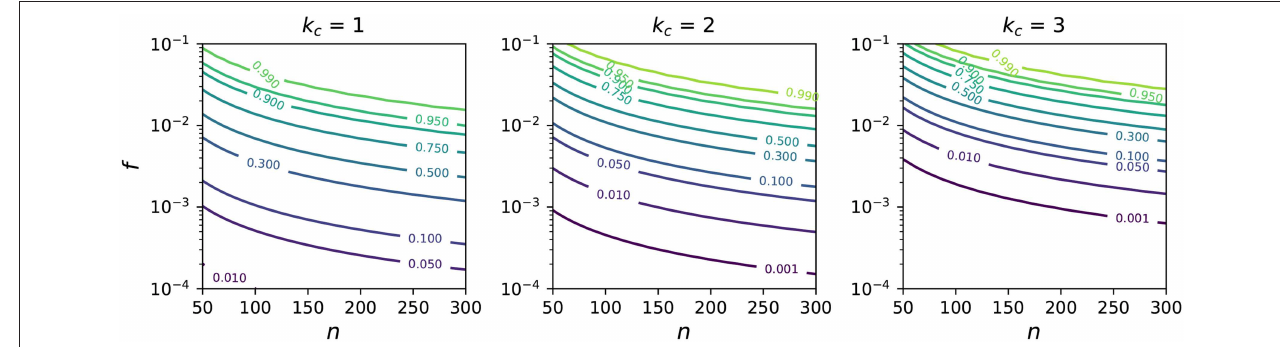
FIGURE 2 | Probabilities of dating enough grains from the youngest constituent to compute an MDA, given that k c grains are required to compute an MDA and that the grains belonging to the youngest age component constituents a fraction f of all dateable grains (Equation 7). The three panels show probability contours for k c = 1, 2, and 3.